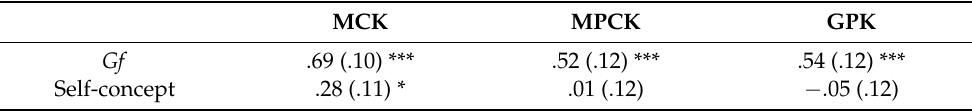
Table 5. Latent multivariate regression model: standardized regression coefficients for the effects of the independent variables gf and academic self-concept on MCK, MPCK, and GPK (standard errors in parentheses).